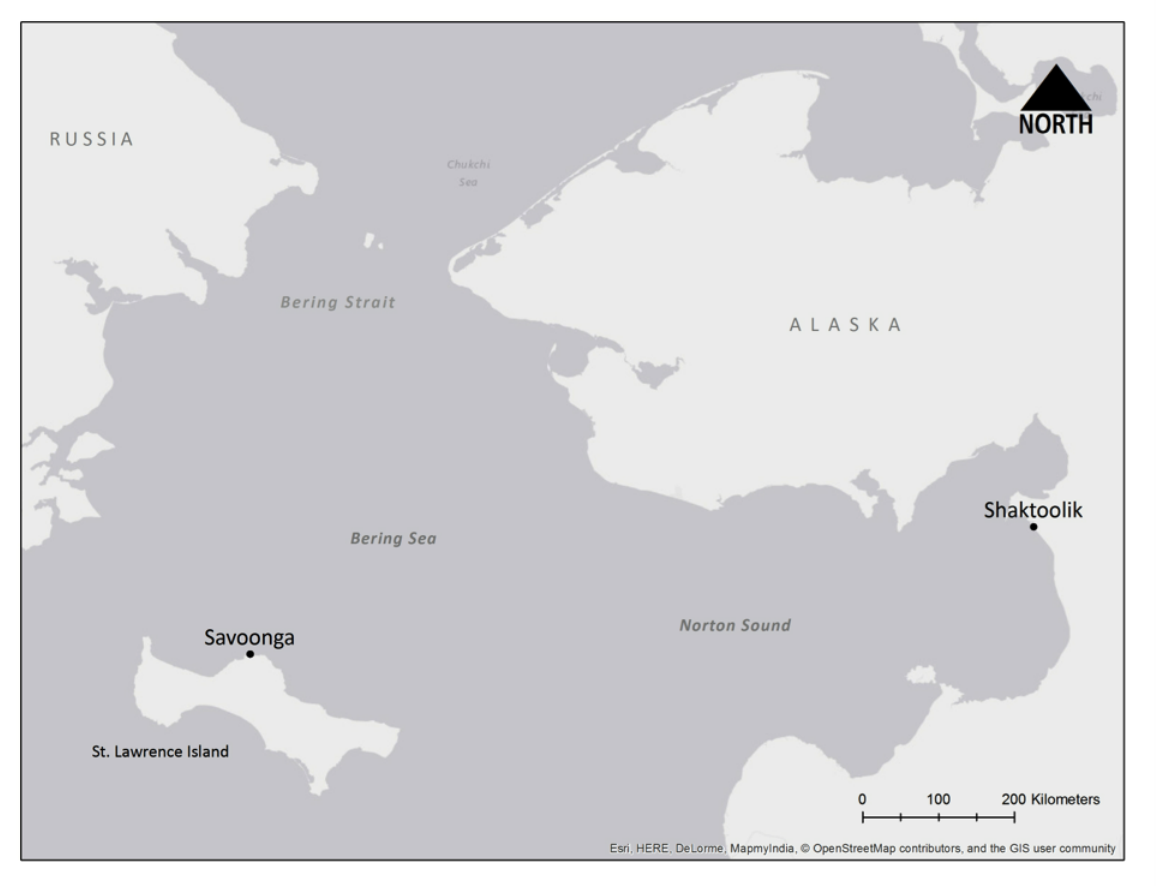
Figure 1. Study sites in the Bering Sea area of western Alaska,